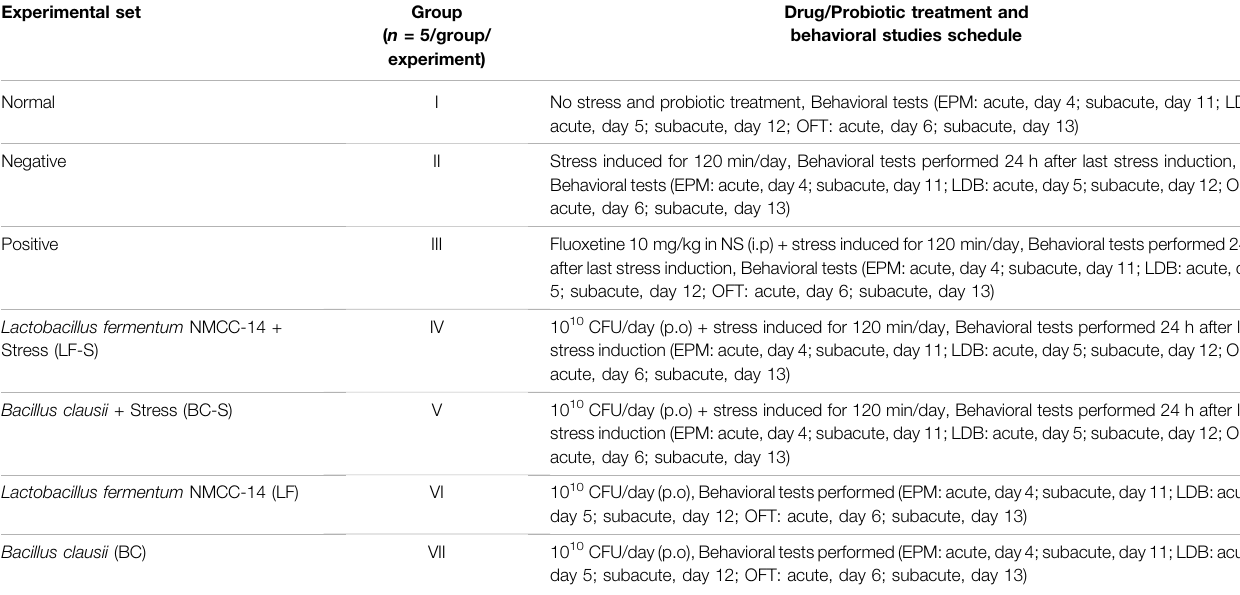
TABLE 1 | Animal groups, probiotic treatment schedule, and behavioral test details. Experimental